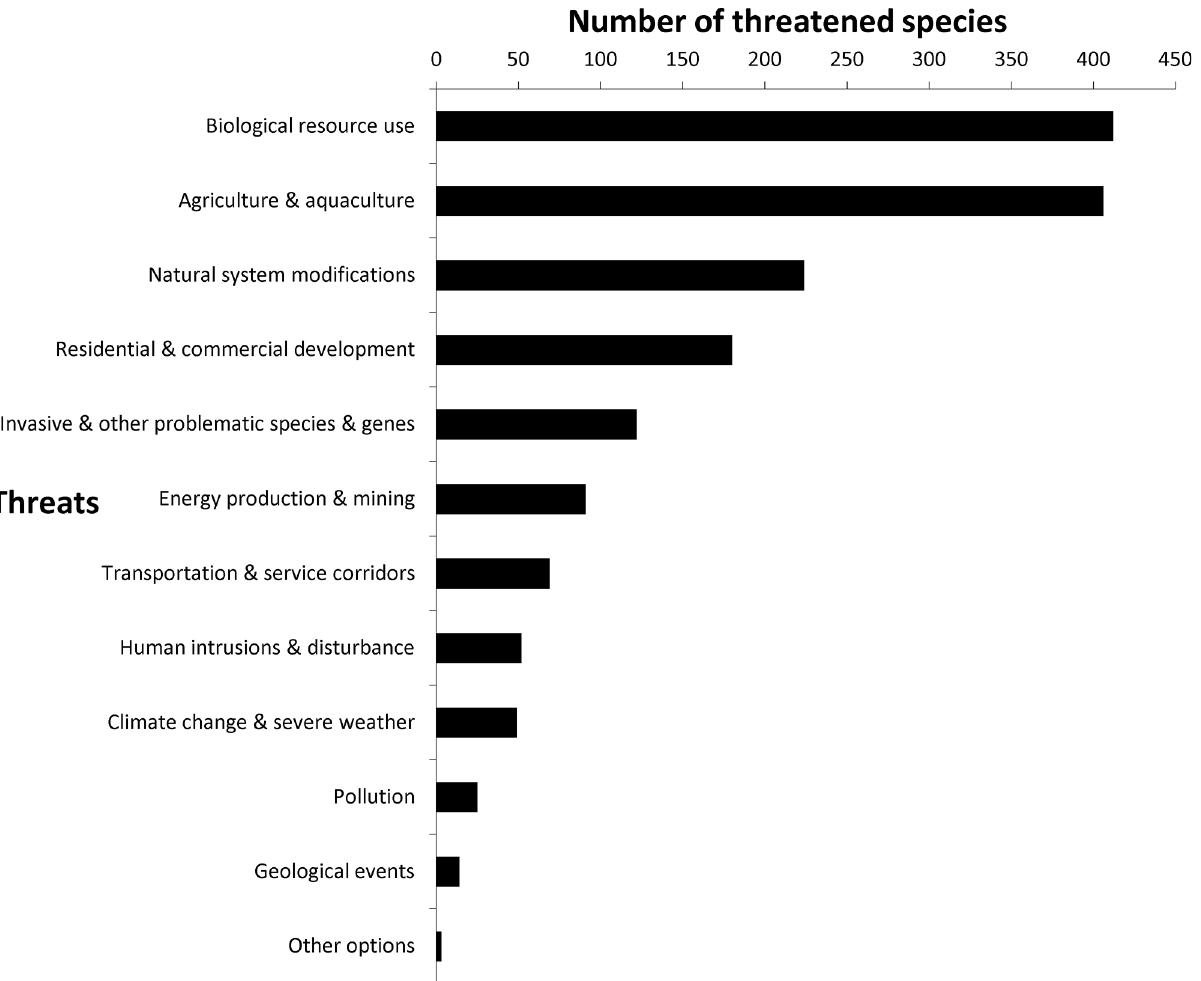
Fig 2. Threats to species from the combined SRLI for Plants sample of gymnosperms, monocots, legumes and pteridophytes, by number of plant species threatened. Individual species may be affected by more than one threat.